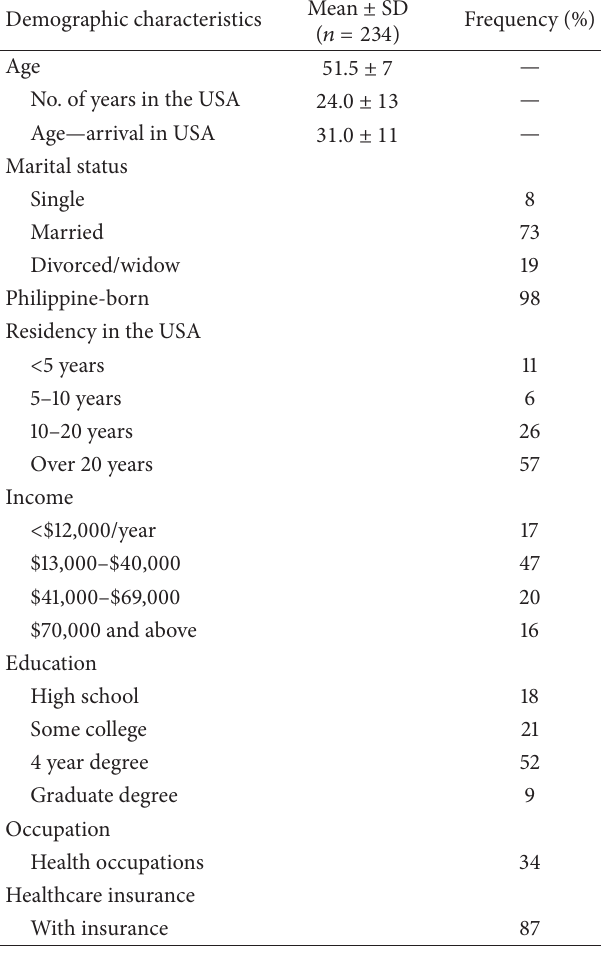
Table 1: Demographic characteristics of the Filipino-American women subjects.